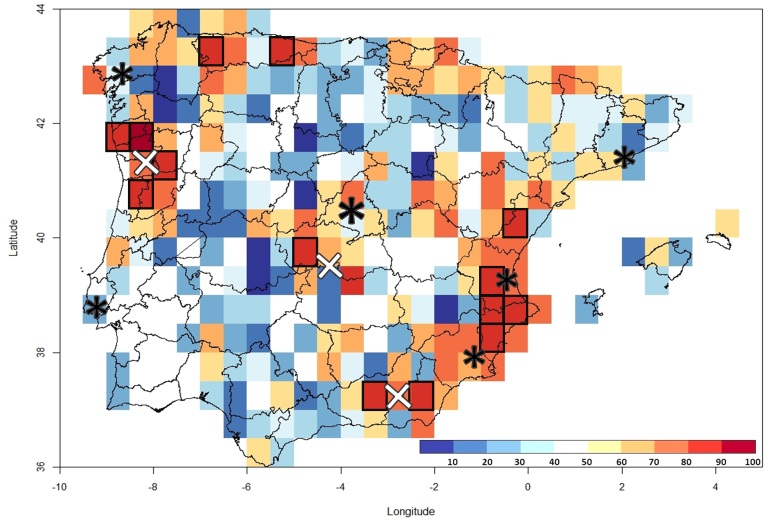
Geographic distribution of inventory completeness in the 1970-2018 period at 30’ resolution, according to the IberBryo v1.1 database. Values close to red represent higher percentages of completeness. Black squares correspond to well-surveyed cells (completeness ≥ 80% and number of records ≥ 10), white X-crosses to PhD theses – from left to right: Helena Hespanhol (NW Portugal), Katia Cezón (Castilla-La Mancha) and Susana Rams (Sierra Nevada) and black asterisks to major Iberian bryologist groups. These main research centres on bryophytes correspond to: Universidad Autónoma de Barcelona, Universidad Autónoma de Madrid, Universidad Complutense de Madrid, Universidade de Lisboa, Universidad de Murcia, Universidad Rey Juan Carlos, Universidade de Santiago de Compostela, Universitat de València, Museo Nacional de Ciencias Naturales (MNCN-CSIC) and Real Jardín Botánico (RJB-CSIC).